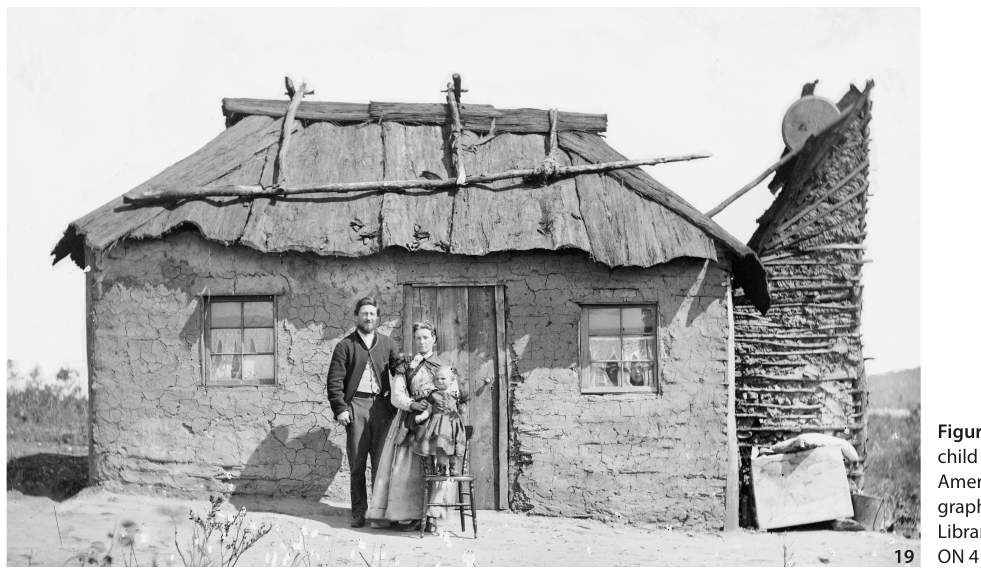
Figure 19 Henry Hunt, wife and child and house, Hill End (Source: American & Australasian Photo- graphic Company, c 1872. State Library of New South Wales, no ON 4 Box 6 No. 18587).